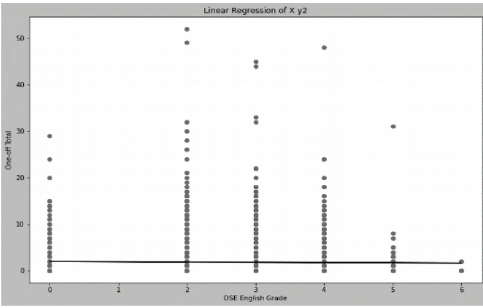
Figure 18. Linear Regression of X y2 in Finding